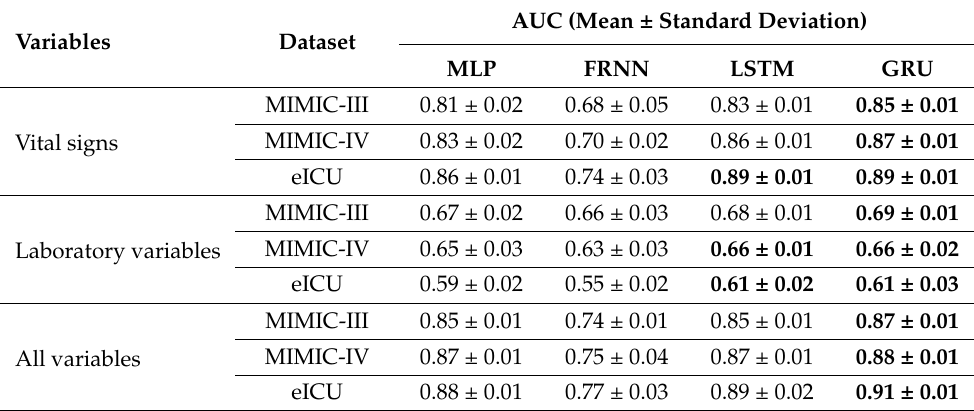
Table 3. Performance of different RNN models with a 48-h observation window (T O =